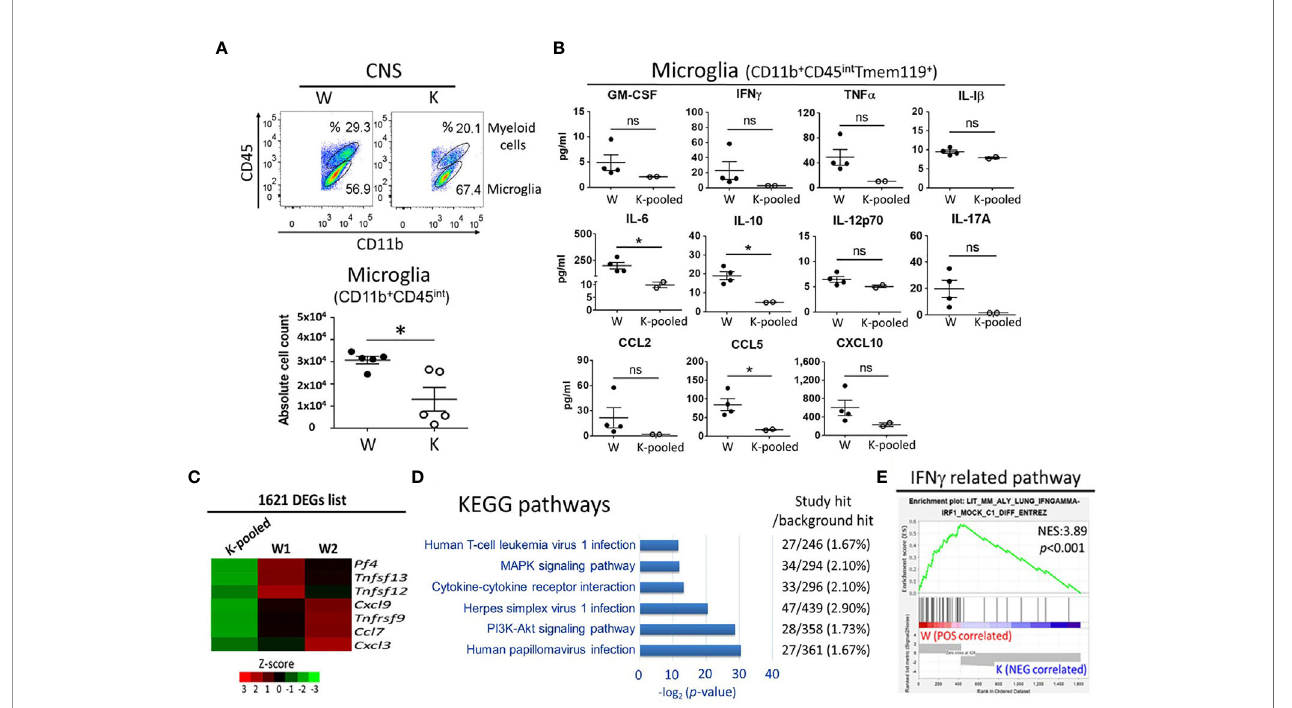
FIGURE 7 | Cytokine/chemokine and transcriptome pro fi les of Nox2-de fi cient microglia. CD11b + CD45 int Tmem119 + microglia were isolated from the CNS tissue of Nox2-competent and de fi cient mice on disease peak (17 dpi). (A) microglia (CD11b + CD45 int ) count analyzed by fl ow cytometry (n = 5 each group). (B) Concentrations of cytokines and chemokines released from primary cultured microglia. [n = 4 (W), 2 (K-pooled)]. MOG: 10 m g/ml. p value: * < 0.05; ns, not signi fi cant. (C) Relative mRNA levels of cytokine/chemokine genes in isolated microglia as determined by RNAseq. Color scales depict relative fold changes. (D) Signi fi cantly enriched KEGG pathways in association with immune response, in fl ammation, infection, and known EAE related pathways. (E) Correlations of the IFN g -related pathway with Nox2-competent and de fi cient microglia transcriptome GSEA. p value: * < 0.05; ns, not signi fi